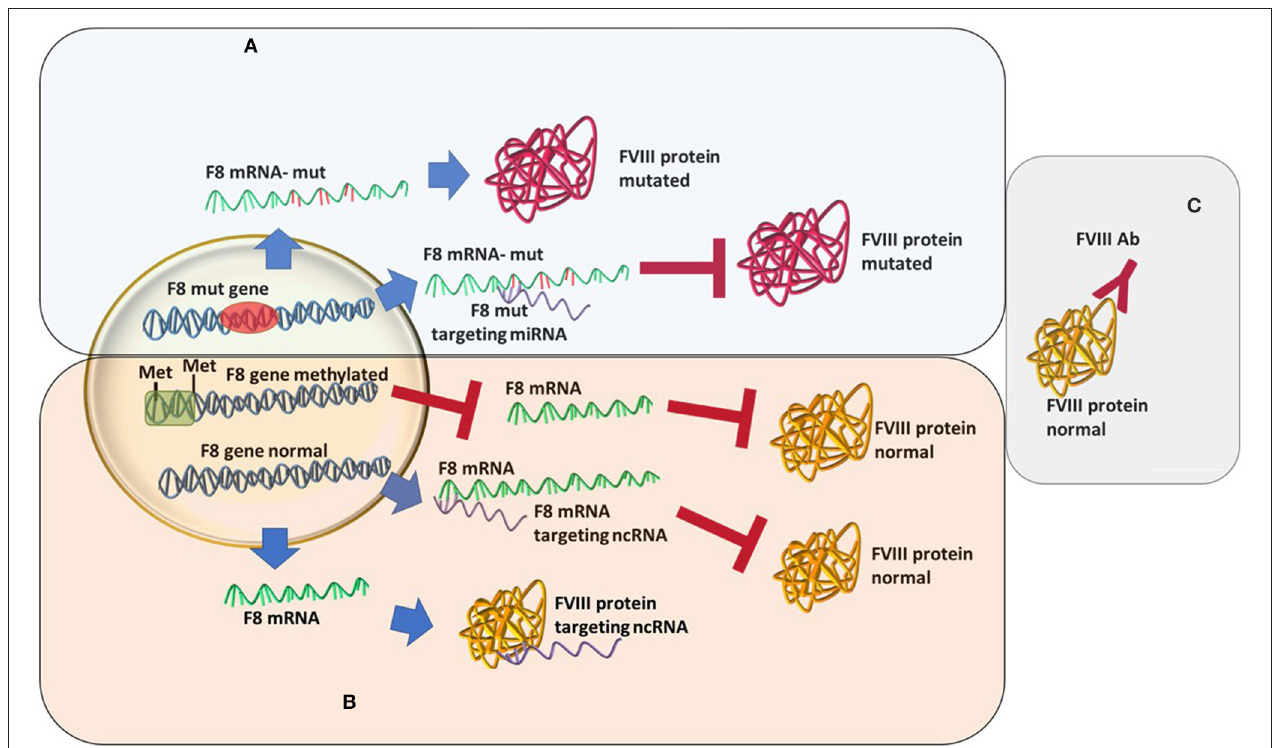
FIGURE 1 | Different types of hemophilia type A and how epigenetic silencing of ncRNA repression might influence the FVIII level regardless of the mutation status. (A) Classic hemophilia-new mutations are found, miRNAs changes in expression increases severity. (B) Non-inherented rare hemophilia-still unclear or lesser known molecular mechanisms. (C) Acquired hemophilia-recently